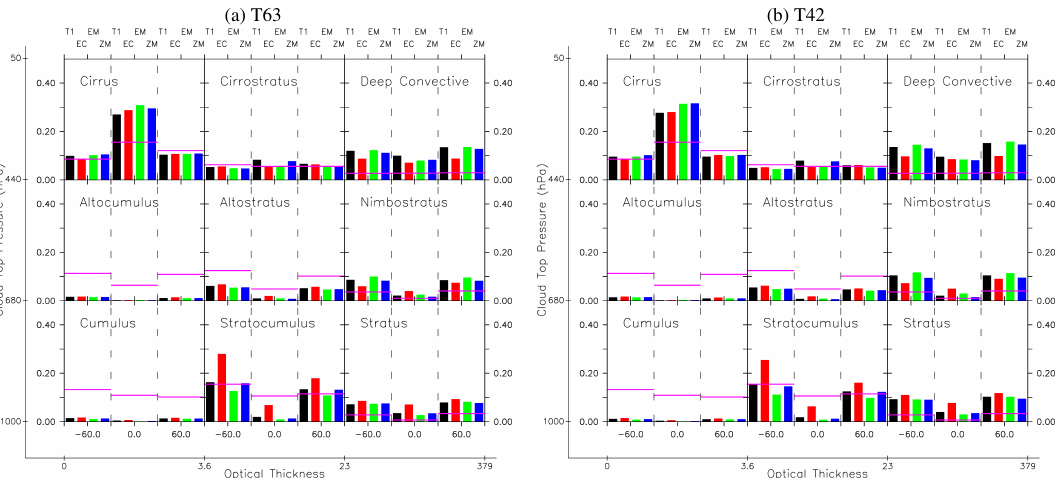
Figure 8. Zonal average occurrence of various cloud types (unit: cloud amount per τ − p c bin). Each bar represents an average over 60 ◦ latitude (90 ◦ S to 30 ◦ S, etc.) for all REF-simulations indicated in the top row of the graphs. The purple horizontal lines show multi-year average values from 1984 until 2008 of the ISCCP D1 dataset (Pincus et al., 2012). The cloud type classification follows the ISCCP definitions by cloud top height and optical thickness. (Rossow and Schiffer, 1999).